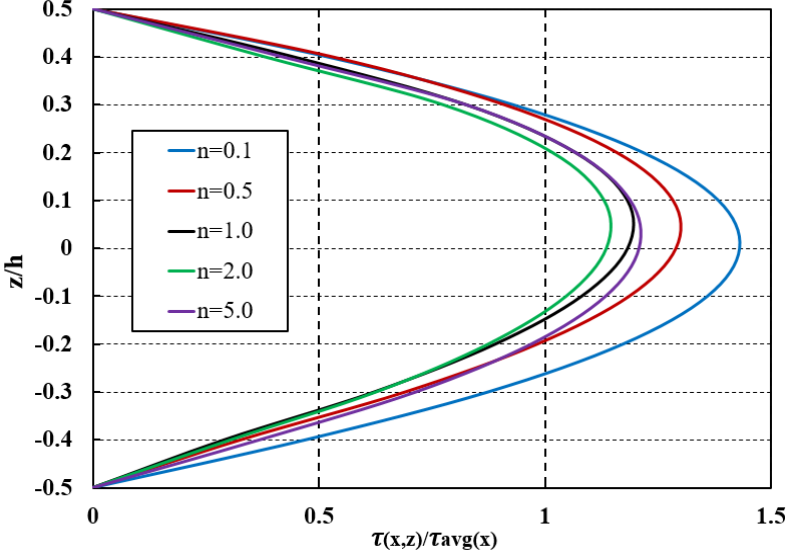
Figure 8. Normalized Shear stress τ xz distribution in simply supported P-FGM beam.